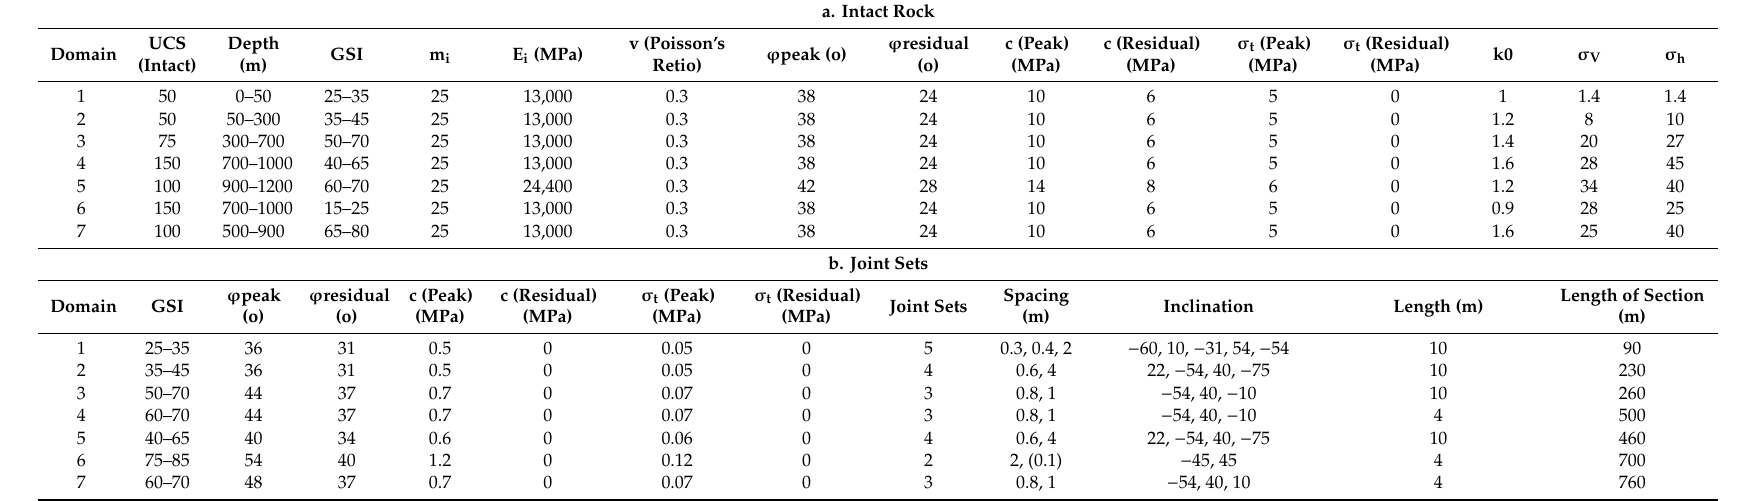
Table 13. Estimated excavation and temporary support measures cost for each Geotechnical Unit. Geotechnical parameters for Scenario II: a. intact rock and b. joint sets (after